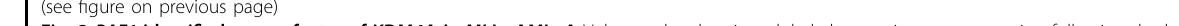
Fig. 3 PAF1 identi fi ed as a cofactor of KDM4A in MLLr-AML. A Volcano plot showing global changes in gene expression following the loss of KDM4A compared to NTC control THP1 cells as identi fi ed by RNAseq. The absolute number of upregulated or downregulated genes that are bound by KDM4A is indicated at the top right and left side of the plot, respectively (KDM4A bound: FDR ≤ 0.01, gene expression: log 2 FC ≥ 0.5 or ≤ − 0.5; adjusted (adj. p ) p ≤ 0.05). B GSEA show overlapping transcriptional consequences following the loss of KDM4A or PAF1 in THP1 cells. Speci fi cally, genes repressed (left panel) or activated (right panel) are upregulated and downregulated, respectively, following the loss of KDM4A 26 . C – H THP1 cells and other indicated human AML cells were transduced with lentiviruses targeting KDM4A or PAF1 for KD, or an NTC. All bar charts show mean ± s.e.m. C Bar chart showing relative expression of KDM4A and PAF1 by QPCR in comparison with NTC control cells following KDM4A KD using two different shRNA constructs ♯ 1 and ♯ 2 in THP1 cells ( n = 3) ( D ) and the other indicated human AML cells and primary AML cells include PX21, containing t(6;11)(MLL-AF6) chromosomal translocation and PX30 t(10;11)(MLL-AF10) (PX number is the Paul O ’ Gorman Leukaemia Research Centre Biobank sample identi fi er) ( n = 3) ( F ); * p < 0.01. E – F Percentage of live cell counts in comparison with NTC control ( E ) in THP1 cells 4 days